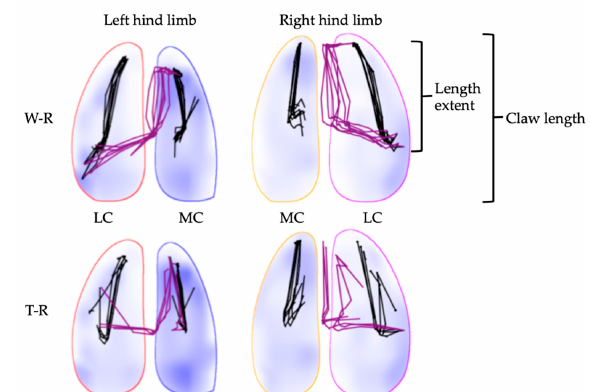
Figure 6. COP_HL (purple) and COP_CL (black) data of one cow are shown for walk (W-R) and trot (T-R) on rubber mats. In this case, the COP_HL pattern is mirrored between both hind limbs for both gaits (L, mirrored L).